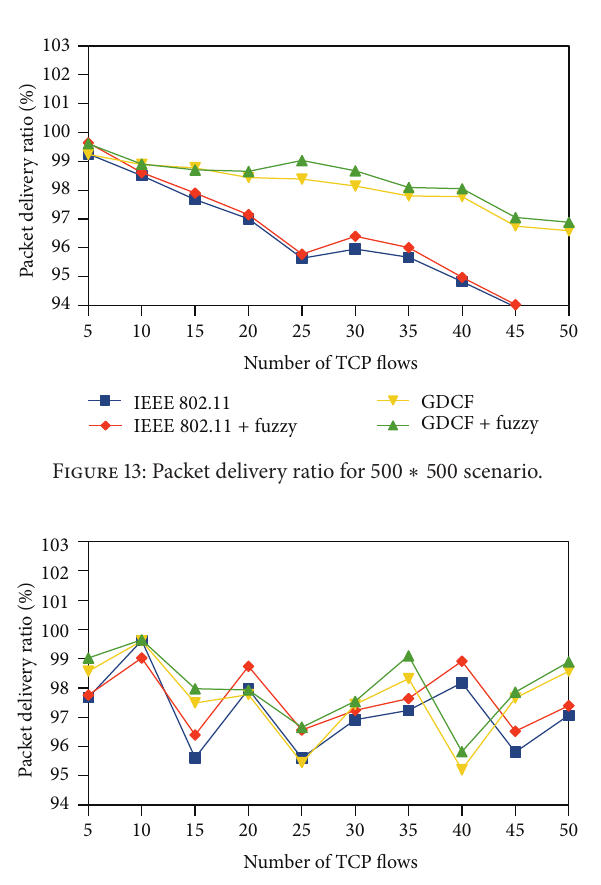
collisions result in unsuccessful transmission that makes the node double the contention window size. Larger contention window size reduces the throughput and increases the delay. The number of collisions in our algorithm is reduced by allocating backoff interval based on nodes buffer status.